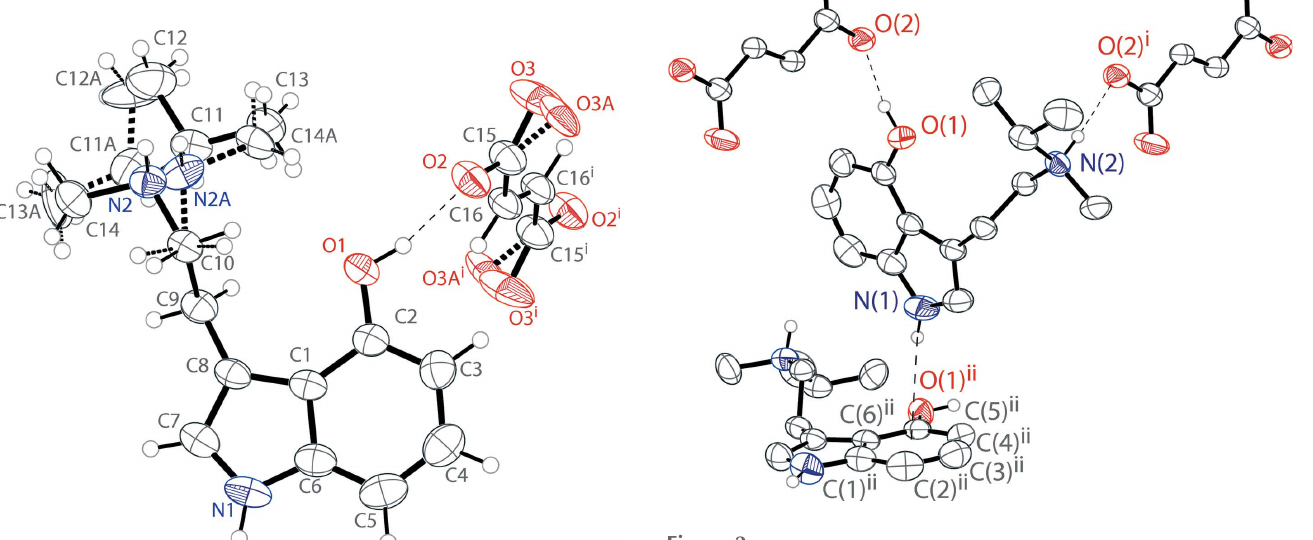
(cid:3) x , 3 (cid:3) y , 2 2